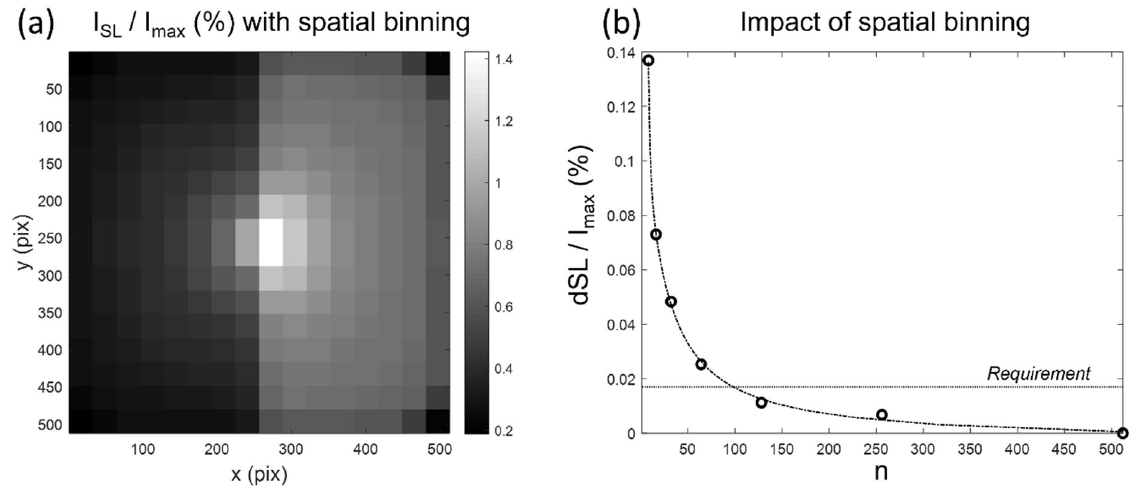
Figure 5. ( a ) SL map for the B and W extended scene illumination, estimated with spatial binning ( n = 16). ( b ) Error on the estimated SL map as a function of the binning n . Field binning consists in averaging the SPST maps associated to neighboring fields.